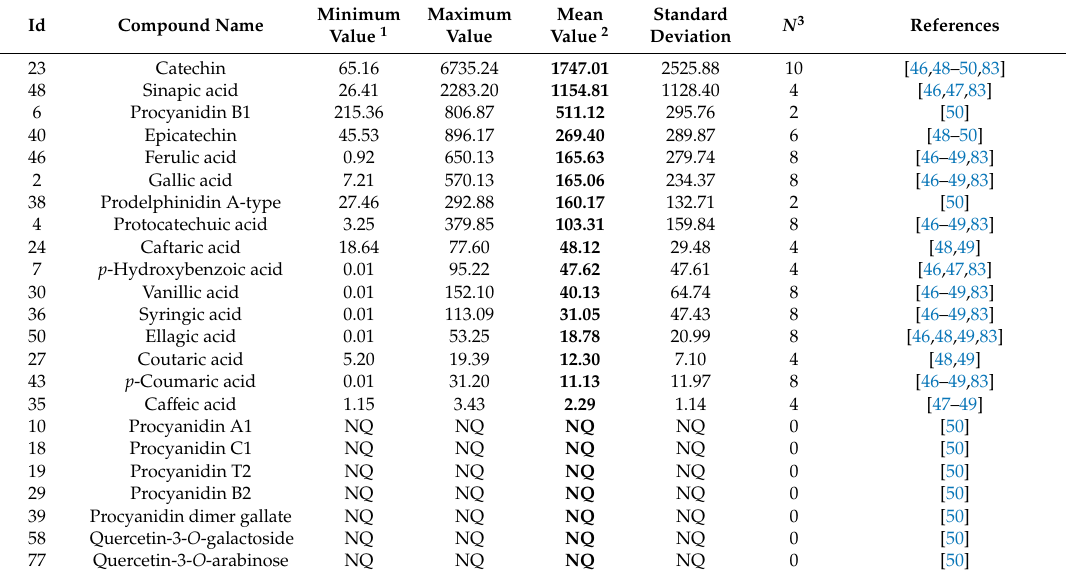
Table 8. Levels (mg / kg) of 23 polyphenols (excluding stilbenes) identified in grapevine